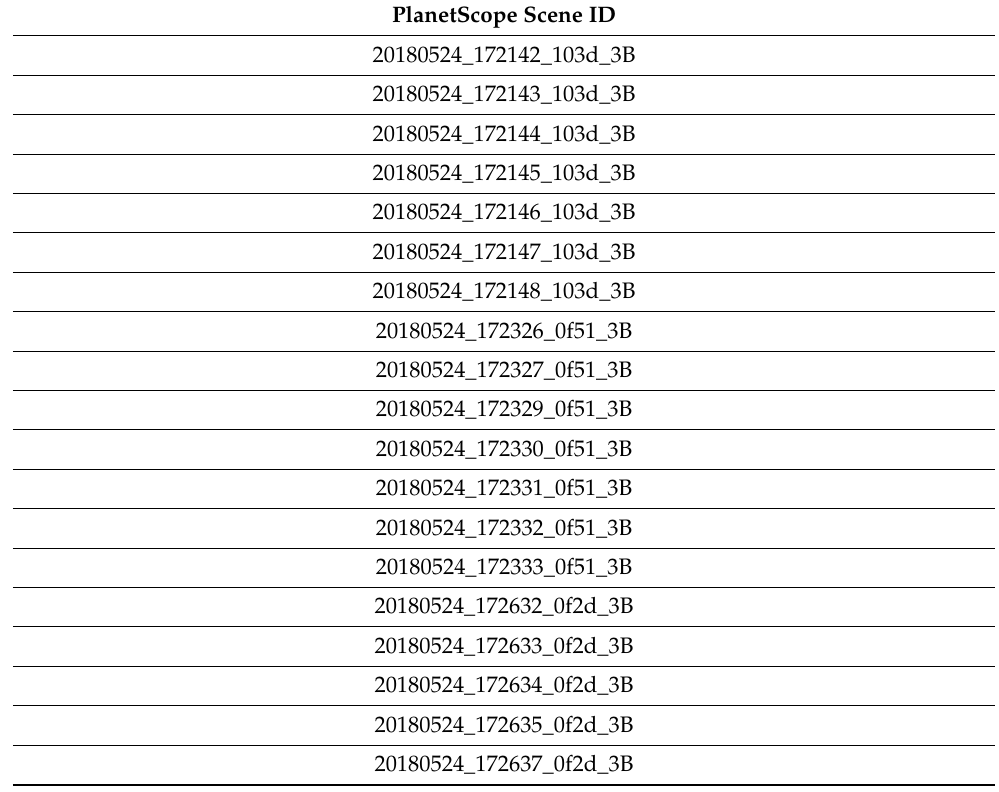
Table A4. 19 Planet Scene IDs (Dove Classic constellation) for Gunnison River Basin, CO, USA.